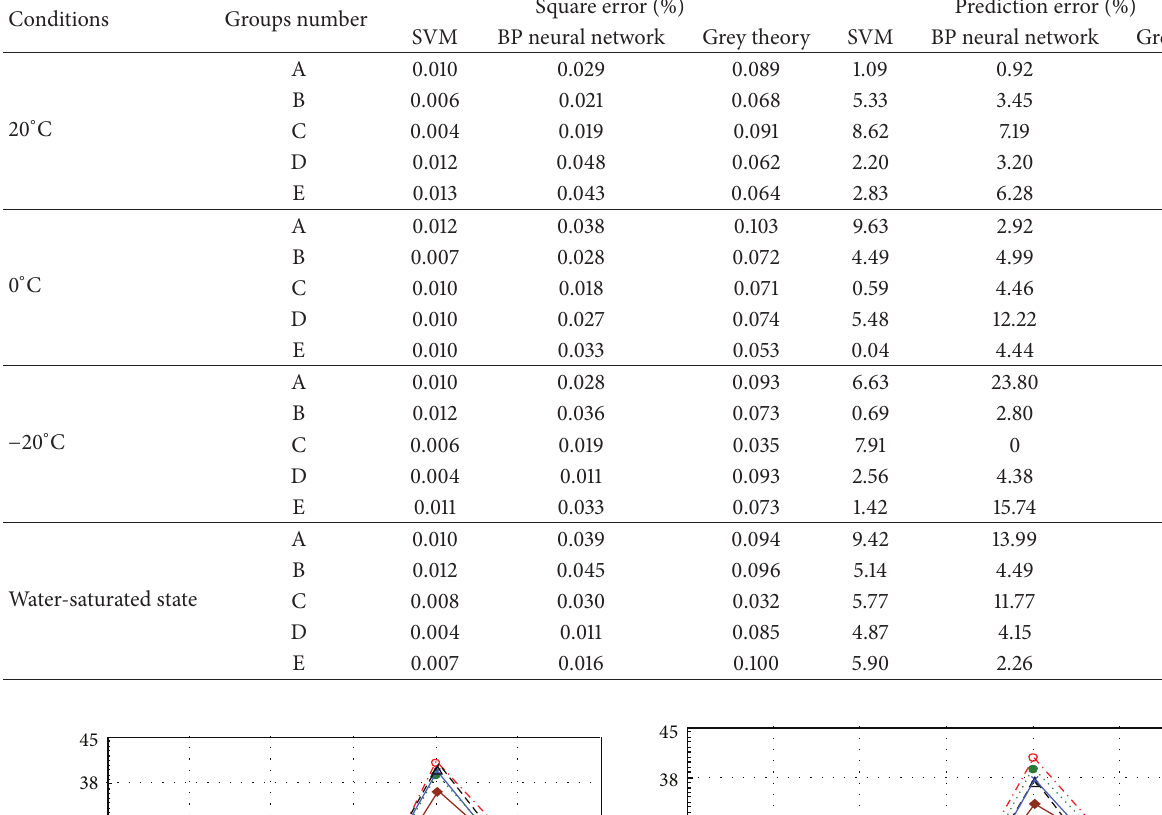
Table 3: Regression and prediction results of SVM, BP, and grey theory.